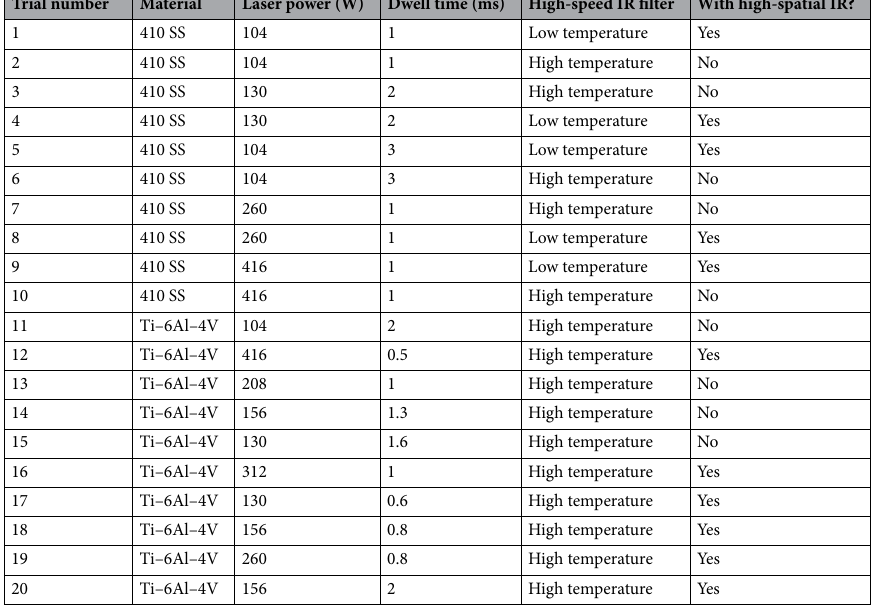
Table 1. Experimental conditions for synchronized X-ray, high-speed IR camera, and high-spatial IR